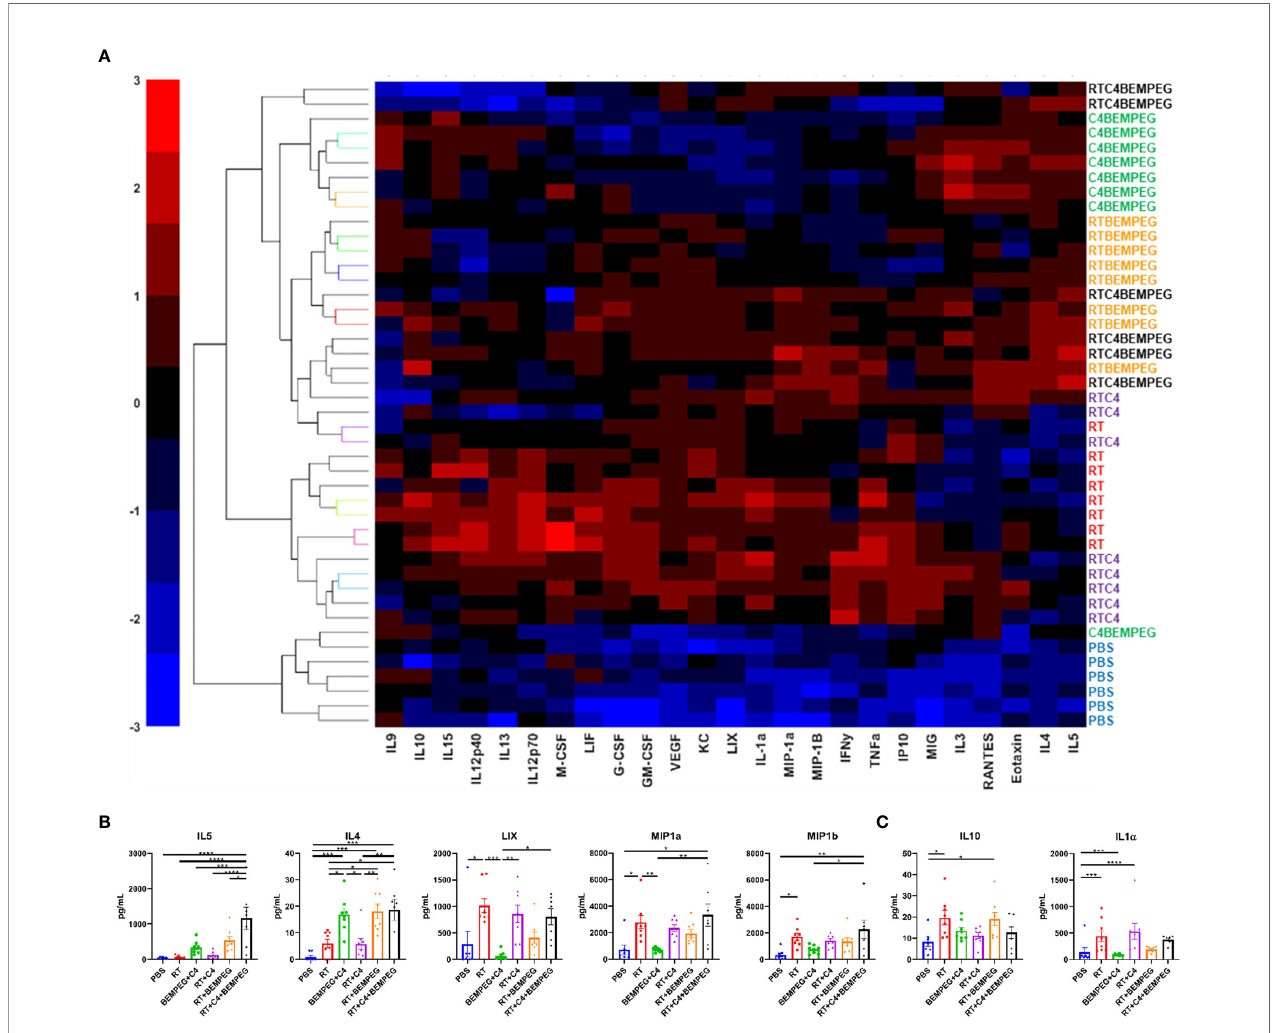
FIGURE 4 | Radiation, anti-CTLA-4, and BEMPEG combined treatments change the cytokine pro fi les of the TME. Mice bearing a fl ank LLC tumor (~80mm 3 ) were given 8 Gy x 3 locally combined with BEMPEG and anti-CTLA-4 (C4) treatments. At day 20 tumors were collected and lysed. Multiplex immunoassay analysis was performed to determine concentrations of 25 cytokines and chemokines. (A) Unbiased hierarchal clustering was used to sort tumors based on detected levels of cytokines and chemokines. (B, C) A one-way ANOVA followed by a Tukey multiple comparisons test was used to determine statistical differences among cell populations, (mean ± SEM, n ≥ 6, **** = P <0.0001; ***=P<0.001; **=P<0.01; *=P<0.05). (B) Concentrations of immune stimulating cytokines and (C) cytokines associated with immunosuppressive or inhibitory functions are